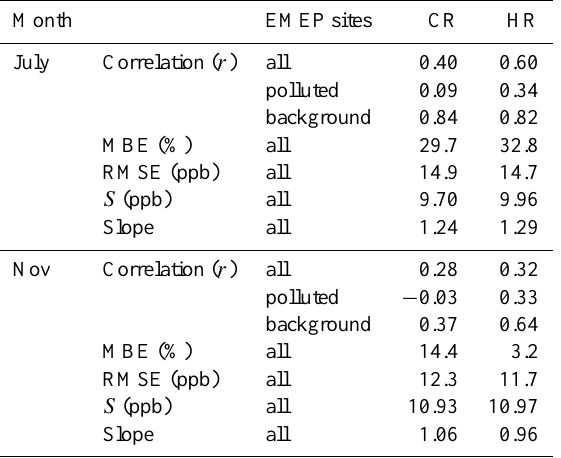
Table 2. UKCA statistical results comparing ozone from the climate (CR) and high resolution (HR) runs to observations from the EMEP network (EMEP, 2007). The subsets of EMEP sites are as defined in the text and shown in Fig. 2. Note that S obs is found to be 9.31ppb and 8.64ppb for July and November